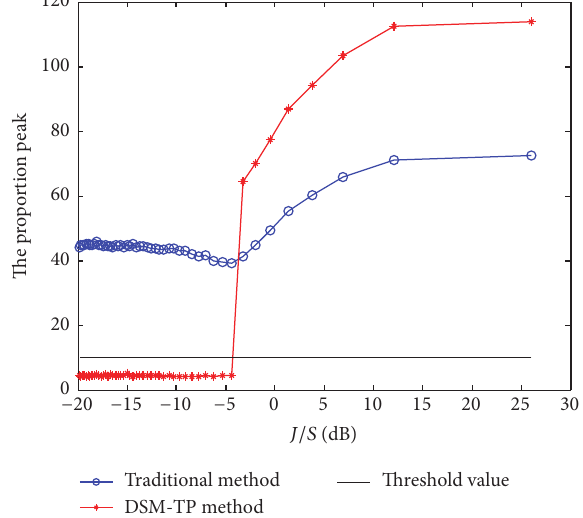
Figure 12: Proportion peak for changing S/J .